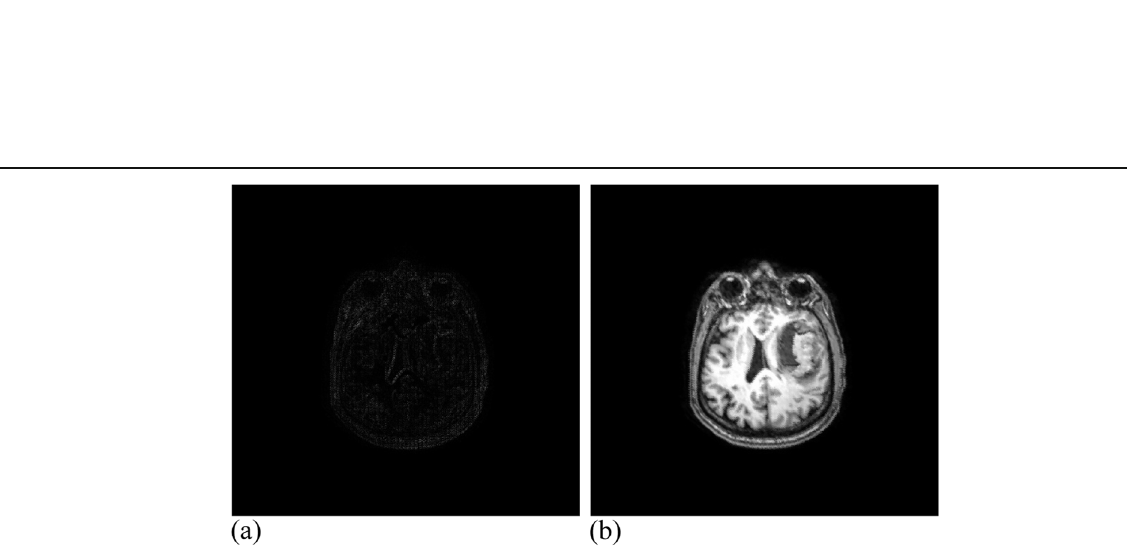
Fig. 14 MRI data after registration. (a) : Difference between MRI reference image and registration image; ( b ): MRI registration image